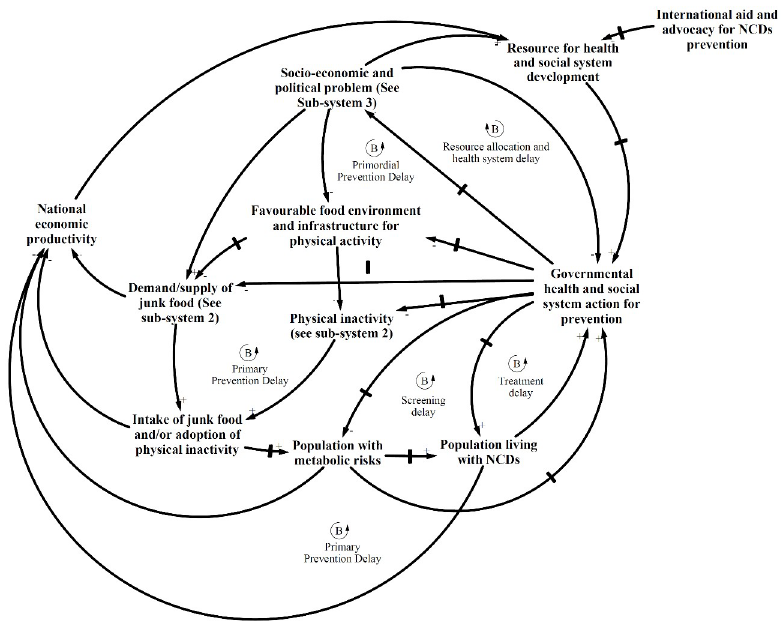
Fig 3. Prevention delay sub-system showing the interaction of governmental response to promote healthy diet and physical activity, other sub-systems and NCDs.